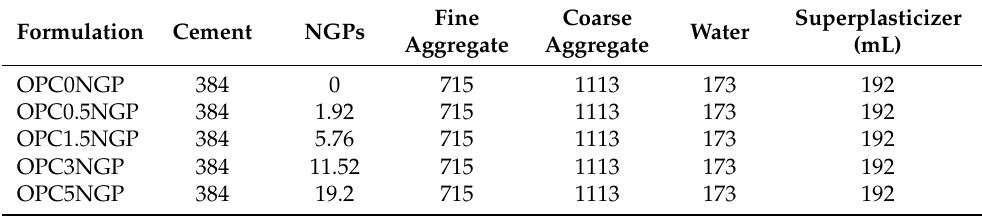
Table 5. Concrete mix proportions in Kg/m 3 . Formulation